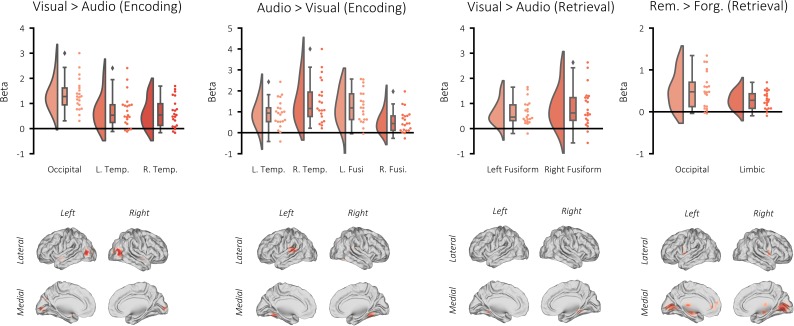
Univariate BOLD contrasts.Top: raincloud plots depicting the contrasted beta weights for each participant. Bottom: brain maps depicting the clusters revealed from the contrasts (non-significant voxels masked). A GLM was created per participant where these events were modelled as stick functions that had been convolved with a canonical hemodynamic response function (HRF). In addition, a regressor modelling button presses, six movement regressors and eight regressors modelling each run were added to the GLM. The derived beta weights for visual perception and auditory perception were then contrasted. The resulting contrast image of each participant was statistically appraised in a one-sample t-test across participants. Using a cluster-forming threshold of puncorr <0.001 and k = 10, three significant clusters showed greater activation during visual perception relative to auditory perception: one in the occipital lobe (pFWE <0.001, k = 975, MNI [x = 42, y = −70, z = 10], Cohen’s d = 2.09), one in the left temporal pole (pFWE = 0.008, k = 67, MNI [x = −48, y = 2, z = −10], Cohen’s d = 1.06), and one in the right temporal pole (pFWE = 0.005, k = 72, MNI [x = 48, y = 5, z = −14], Cohen’s d = 1.11). Four significant clusters showed greater activation during auditory perception relative to visual perception: two bilaterally in the auditory cortex (left: pFWE <0.001, k = 324, MNI [x = −63, y = −31, z = 14], Cohen’s d = 1.35; right: pFWE <0.001, k = 217, MNI [x = 60, y = −31, z = 14], Cohen’s d = 1.47), and two bilaterally in the fusiform gyrus (left: pFWE <0.001, k = 112, MNI [x = −24, y = −49, z = 14], Cohen’s d = 1.18; right: pFWE <0.001, k = 203, MNI [x = 27, y = −49, z = −18], Cohen’s d = 1.00). Two significant clusters showed greater activation during visual retrieval relative to auditory retrieval: one in the left fusiform gyrus (pFWE = 0.001, k = 89, MNI [x = 21, y = −37, z = −14], Cohen’s d = 1.05), and one in the right temporal pole (pFWE = 0.001, k = 99, MNI [x = −30, y = −46, z = −6], Cohen’s d = 1.33). No clusters showed greater activation during auditory retrieval relative to visual retrieval. Two significant clusters showed greater activation during successful visual memory retrieval relative to unsuccessful visual memory retrieval: one in the occipital lobe (pFWE <0.001, k = 1178, MNI [x = 12, y = −52, z = −14], Cohen’s d = 1.21), and one spanning the limbic system, including the hippocampus (pFWE <0.001, k = 1447, MNI [x = −21, y = −16, z = 2], Cohen’s d = 1.33). No clusters showed greater activation during successful auditory memory retrieval relative to unsuccessful auditory memory retrieval.